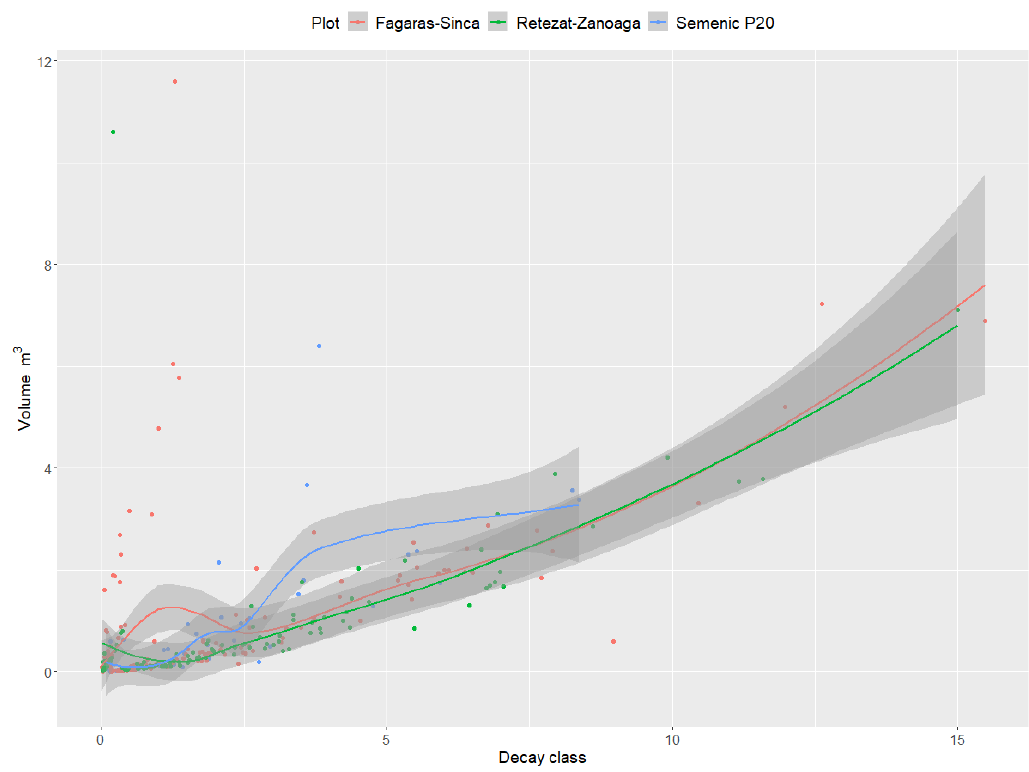
SDW, high values were only found in the Semenic P20 plot. The value of this indicator Figure 5. Relationship between DW surface and volume. Figure 5. Relationship between DW surface and volume. was very low in the other plots. The SV ratio index registered high values in the LDW decay class (category L2) (Figure 6). The recorded values are high for all the plots with category L1, indicating the highest values of this index was found for the Retezat – Zanoaga plot. In terms of the